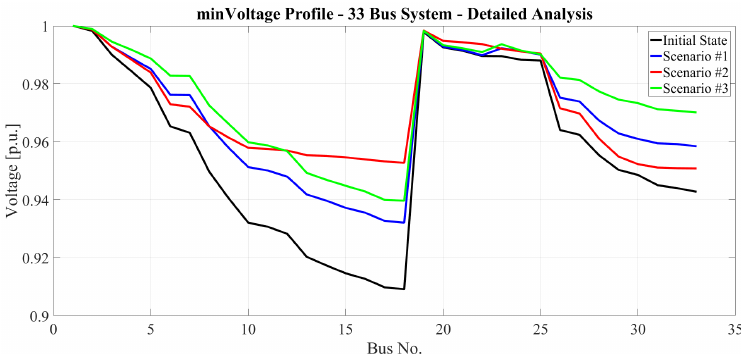
Figure 20. Detailed Analysis—Minimum Voltage profile for all Scenarios.